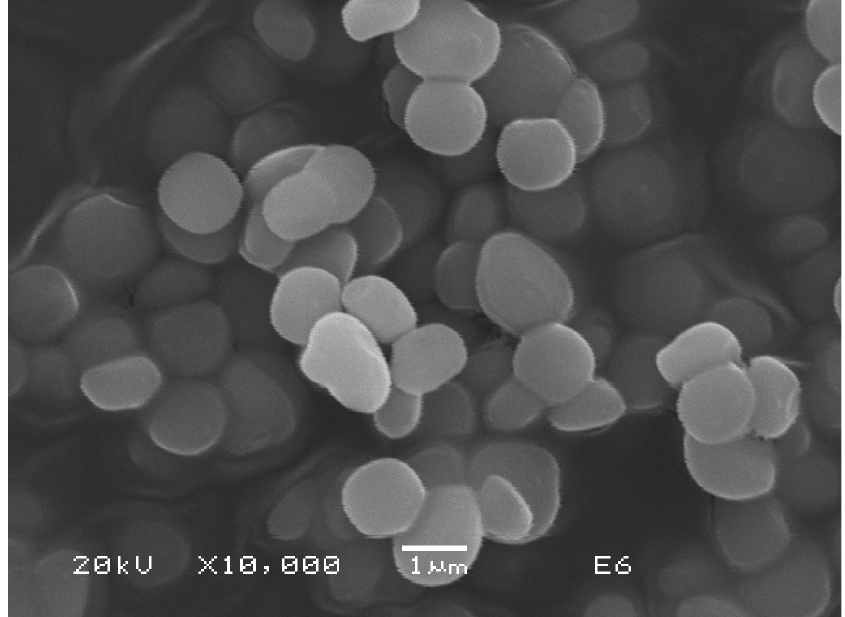
Figure 4. SEM (SE) images of potassium jarosite obtained in the synthesis stage (magnification of 10,000 × ). Table 2. Average punctual chemical analysis of potassium jarosite synthesized at 75 °C for 9 h (SEM ‐ EDS).